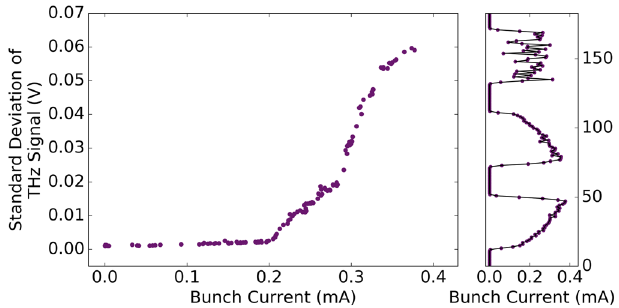
FIG. 4. Standard deviation of the THz signal of each bunch as a function of the corresponding bunch current, revealing the onset of bursting emission ( “ bursting threshold ” ) at 0.2 mA. The individual bunch currents (shown on the right) were patterned to equally sample the whole bunch current range (adapted from